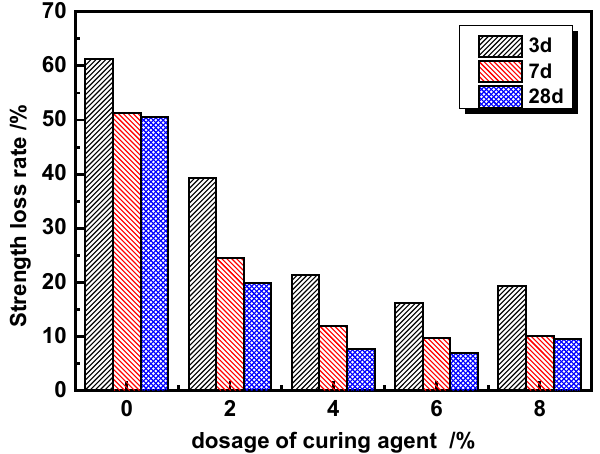
Figure 5. Strength loss rate of stabilized silt after immersion.